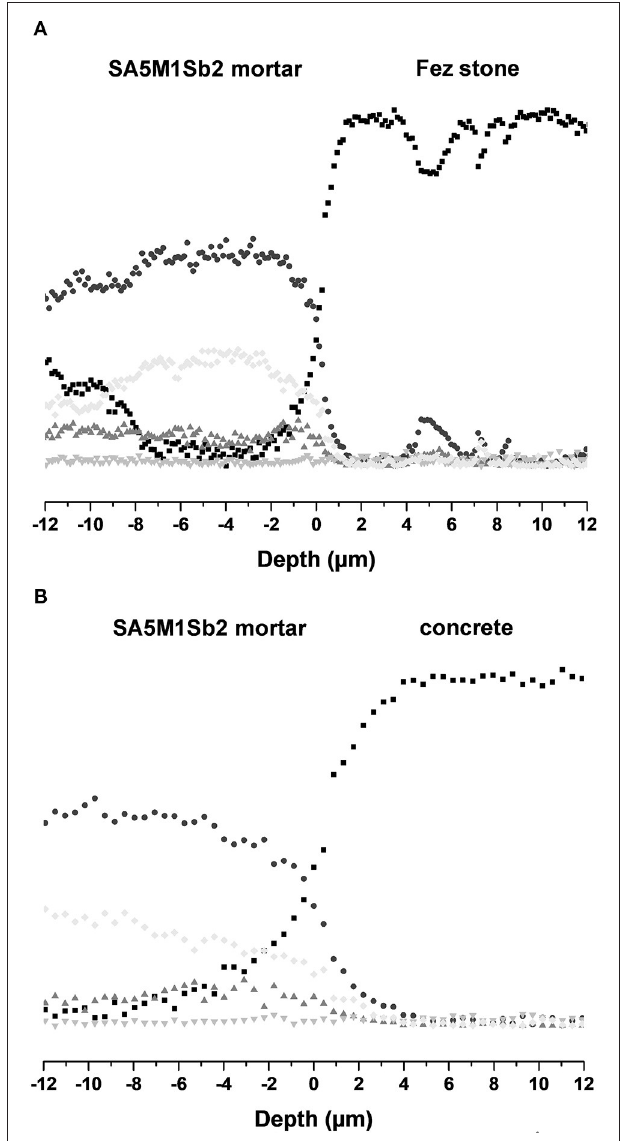
FIGURE 8 | Concentration profiles of ( (cid:8) ) Si (K α = 1, 739 keV), ( (cid:7) ) Al (K α = 1,486 keV), ( N ) K (K α = 3,312 keV), ( H ) Mg (1.254 KeV), and ( (cid:4) ) Ca (K α = 3,690 keV) elements at the interface of the coating SA5M1Sb2 applied on (A) Fez stone and (B)